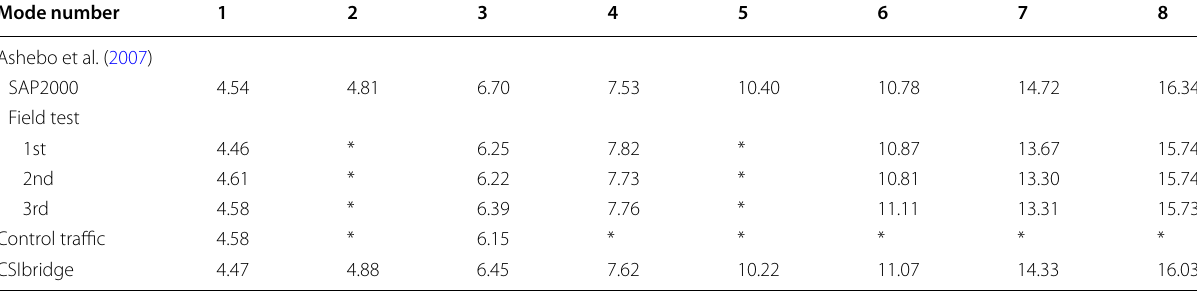
Table 2 Comparison between field test and FEA.